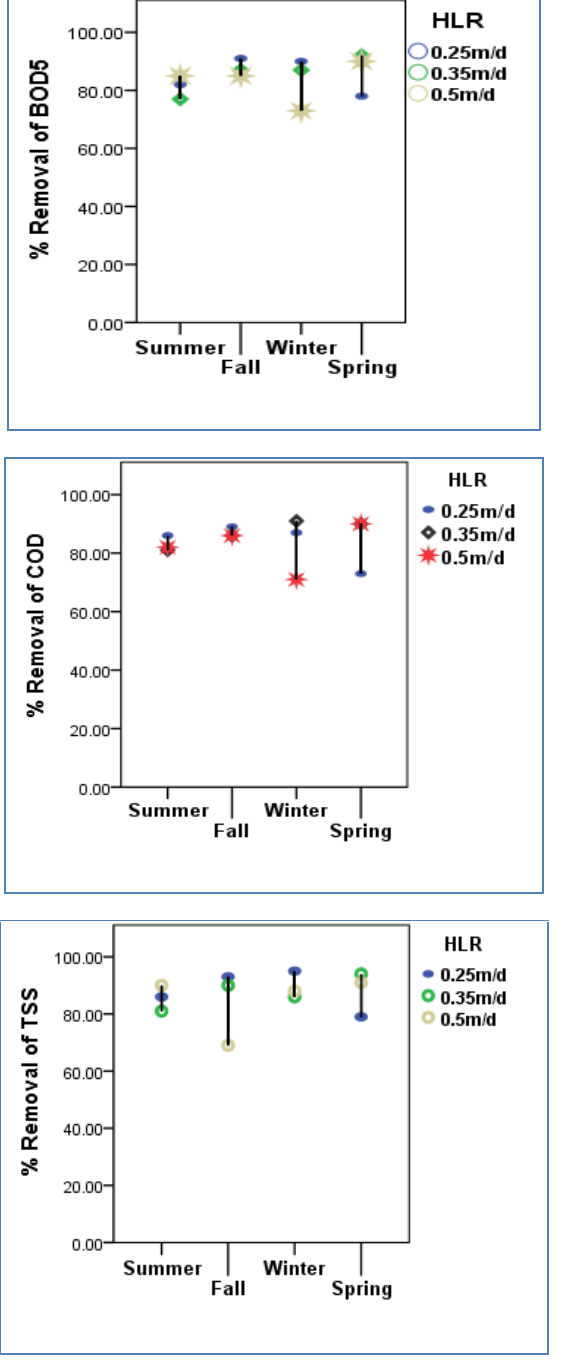
Figure 7. Performance of V-MSL to remove organic matters